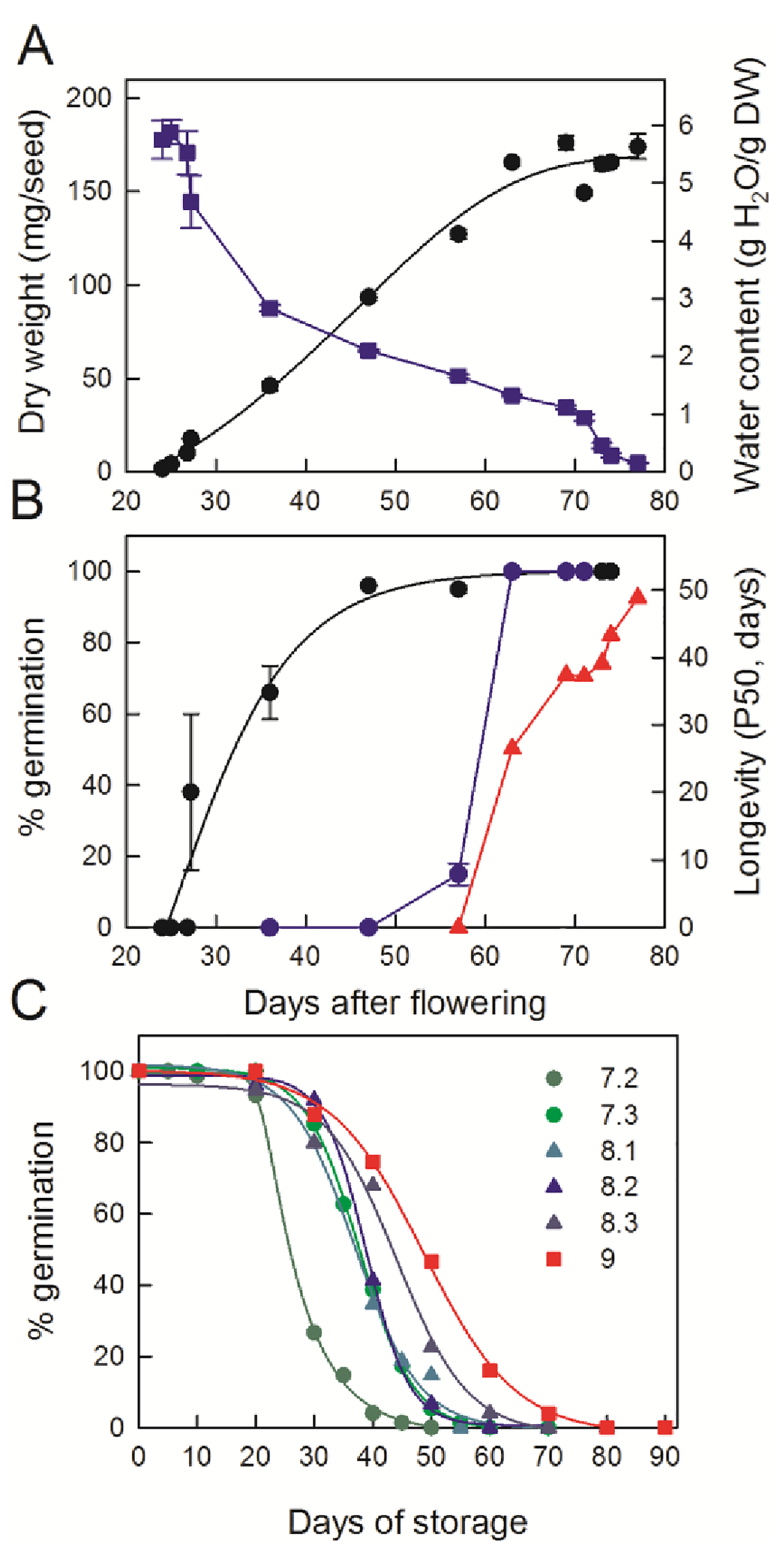
Fig 2. Physiological characterization of soybean seed maturation. (A) Evolution of seed dry weight (back circle) and water content (blue square). Data are the means ( ± SE) of 3 to 5 replicates of 20 seeds. (B)